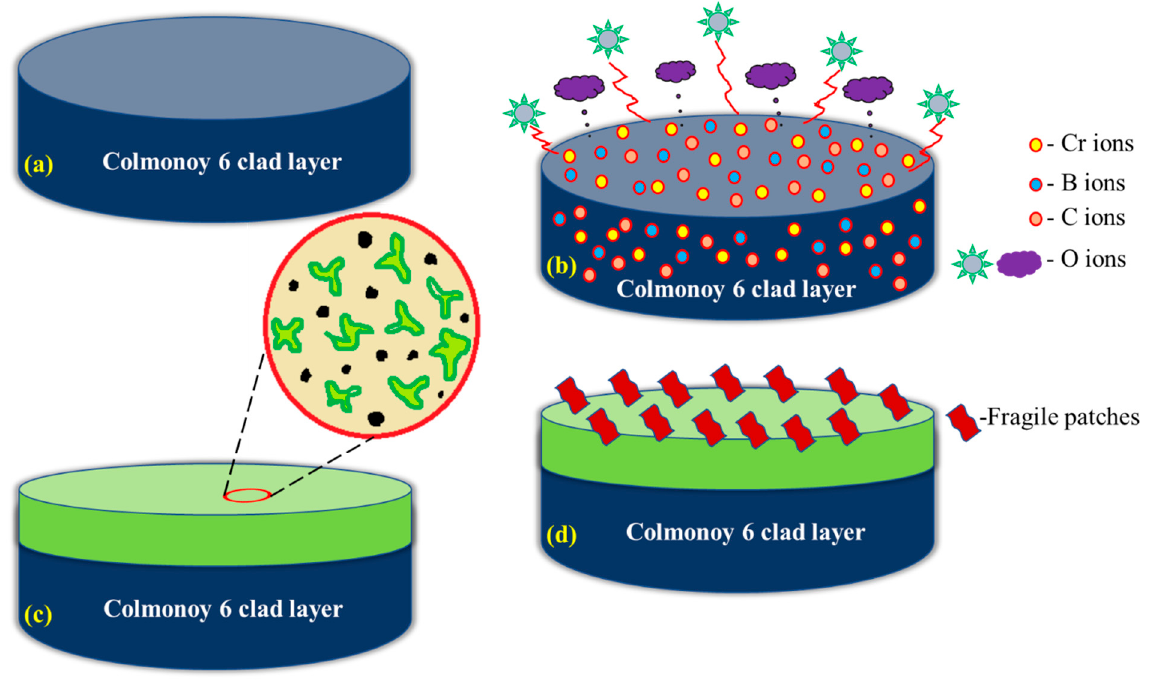
Figure 9. Schematic illustration of passivation layer formed on the clad layer ( a ) Colmonoy-6 clad layer, ( b ) Reaction of Cr, C, B ions present in the Colmonoy-6 with oxygen ions, ( c ) Formation of passive film on the Colmonoy-6 layer which resists corrosion, and ( d ) Fragile passive patches start to leave from the surface.